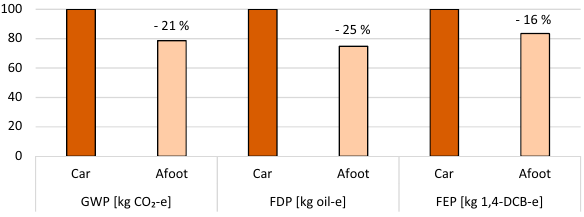
Fig. 4 Comparison of the last mile scenarios "Car" (100%) and "Afoot" (proportionately to the 100%) in the three impact catego- ries climate change (GWP), fossil depletion (FDP) and freshwater ecotoxicity (FET). The graph includes all life cycle phases of pasta